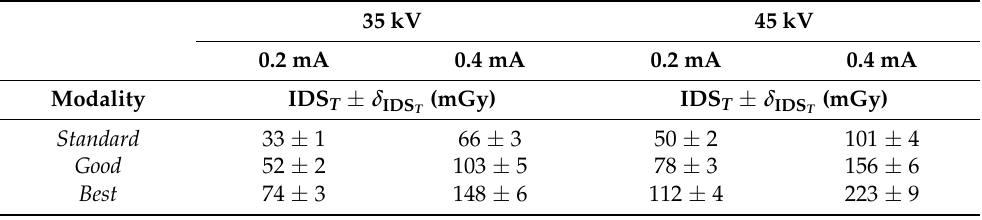
Table 4. Imparted Dose at Surface theoretically calculated (IDS T ) for a cylindrical water phantom (24 mm diameter) for the different microCT parameters of imaging